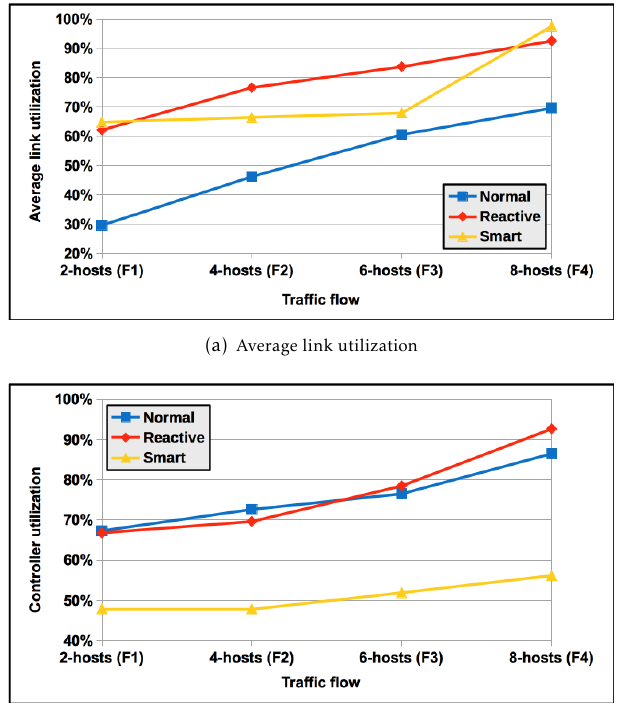
Figure 7. Network resource